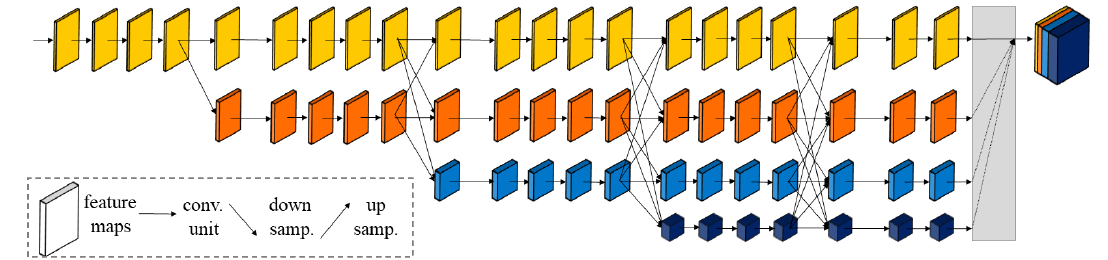
Figure 4. HRNet structure